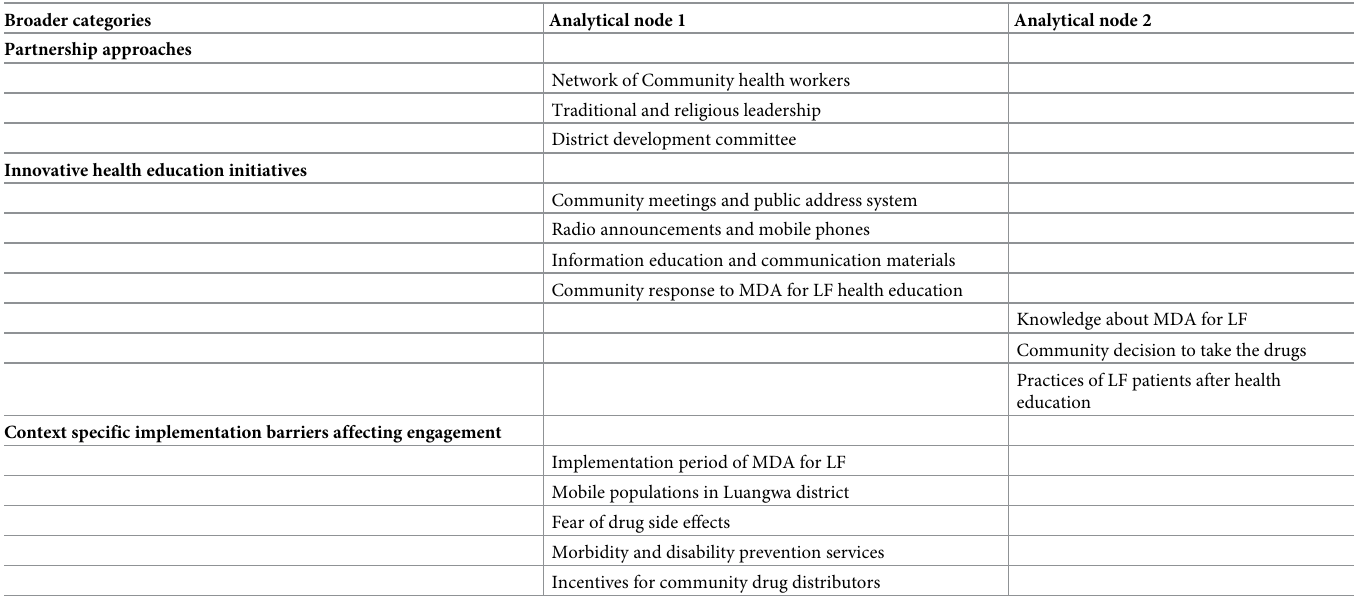
Table 4. Qualitative data analysis